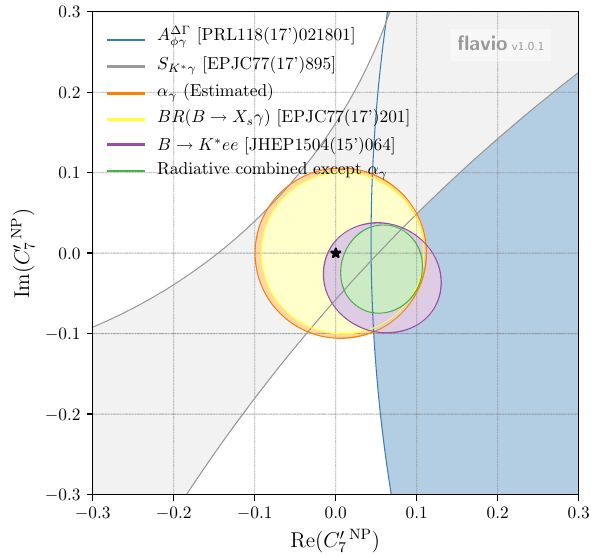
) − Im ( C (cid:7) ) using flavio [59, 7 7